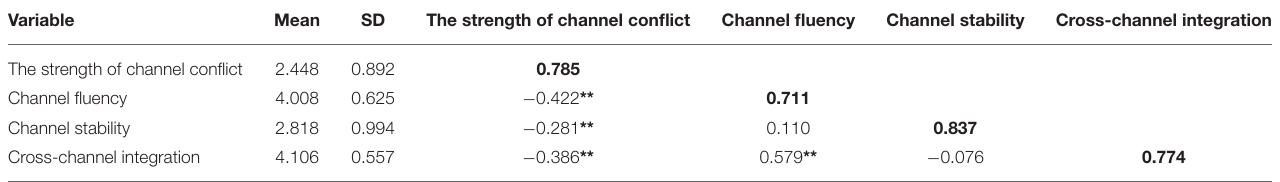
TABLE 3 | Means, standard deviations, and correlation coefficients of